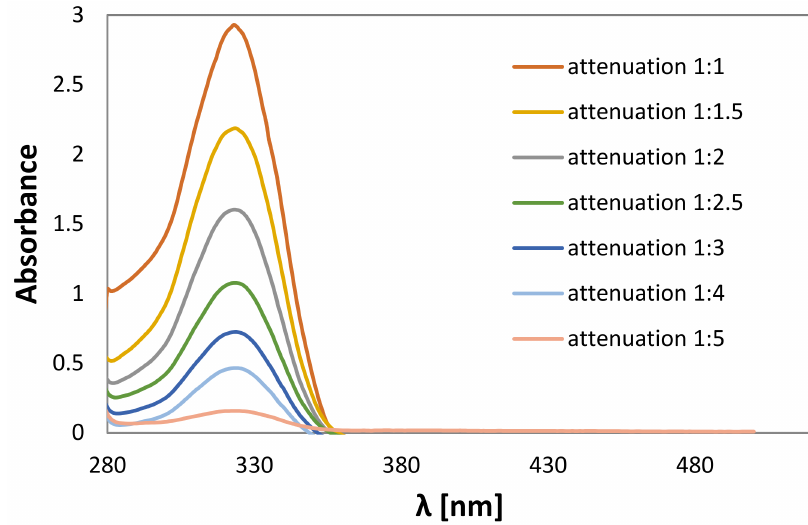
Figure 8. UV-vis absorbance spectrum of vitamin B6 (Pyridoxal phosphate).